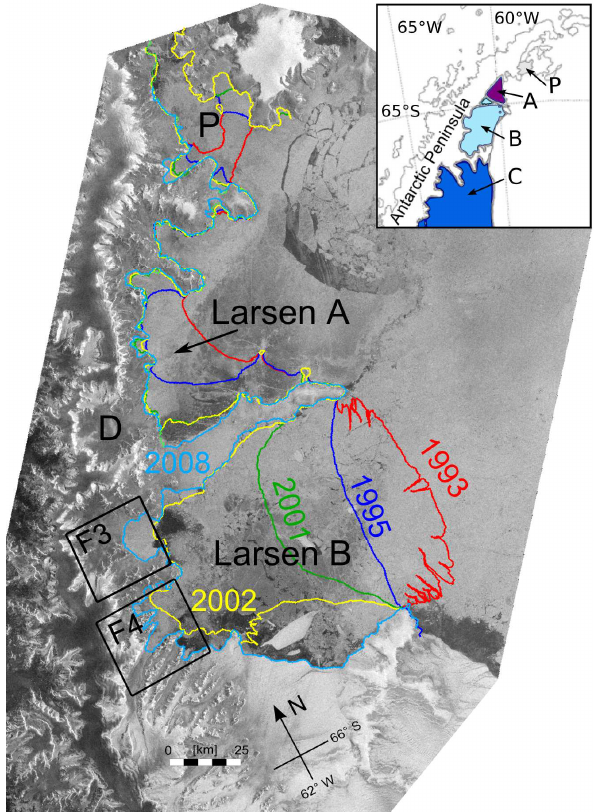
Figure 1. Section of Envisat ASAR Wide Swath image of the northern Larsen Ice Shelf, 6 Fig. 1. Section of Envisat ASAR Wide Swath image of the northern March 2008, geocoded. P - Former ice shelf in Prince Gustav Channel. Red, blue, green, Larsen Ice Shelf, 6 March 2008, geocoded. P – Former ice shelf in yellow, cyan line: Ice edge on 8 December 1992, 30 Jan. 1995, 6 Oct. 2000, 18 March 2002, Prince Gustav Channel. Red, blue, green, yellow, cyan line: ice edge on 26 August 1993, 30 January 1995, 6 October 2001, 18 6 March 2008. D - Drygalski Glacier. F3, F4: Location of Fig. 3, Fig. 4. March 2002, 6 March 2008. D – Drygalski Glacier. F3, F4: location of Figs. 3,